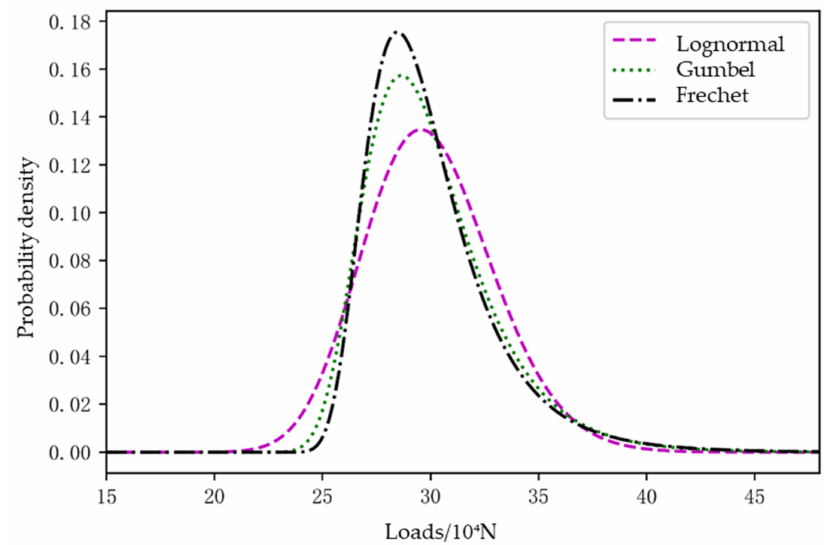
Figure 11. Probability density distribution of three different distributed